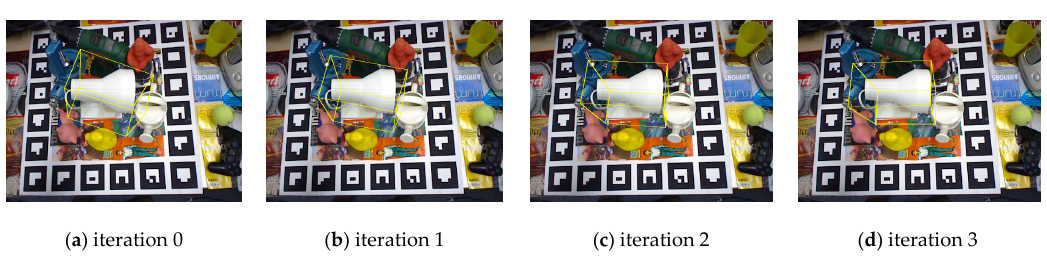
Figure 5. The evolving process of the estimated pose during the refinement process, for the scene shown in the far right column in Figure 4.